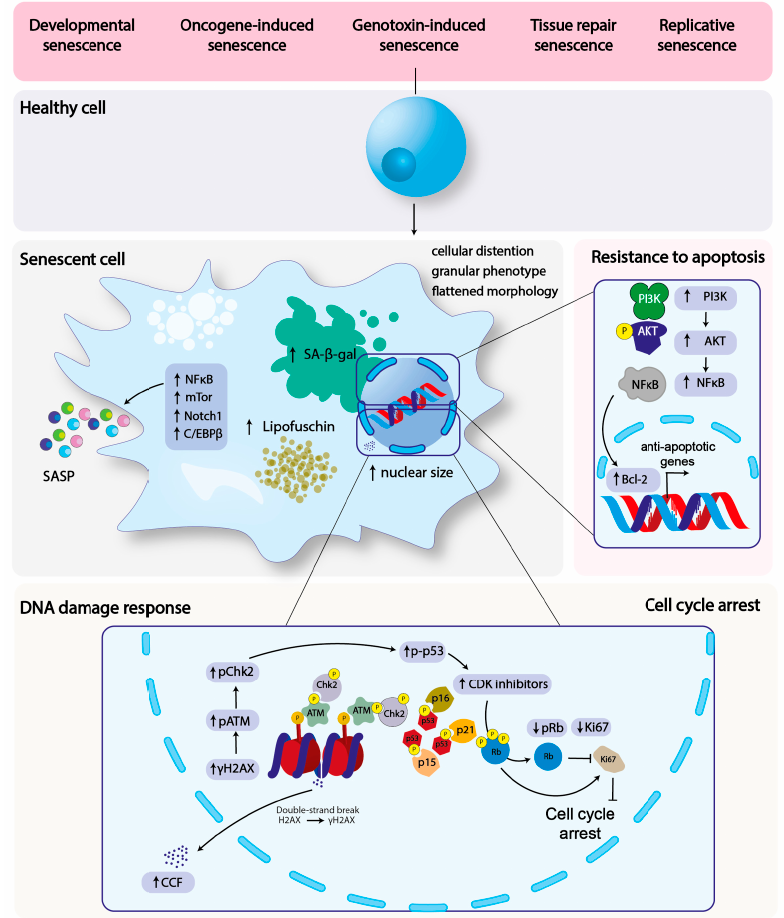
Figure 1. Senescence-triggering factors and the features of senescent cells . The figures summarised the four key features of senescence relevant for the host–pathogen interaction (cell cycle arrest, DNA damage response, SASP and resistance to apoptosis), and the key molecules involved in each of these processes. Senescence can be induced by several stimuli, such as telomeres erosion (replicative senescence), the over-activation of oncogenes, which will induce replication stress and consequent chronic DNA damage (oncogene-induced senescence), chronic DNA damaged caused by exogenous or endogenous genotoxic agents (e.g., chemotherapy, irradiation, oxidative stress, genotoxic-induced senescence). Physiological types of senescence also occur during embryonic development (developmental senescence) or tissue